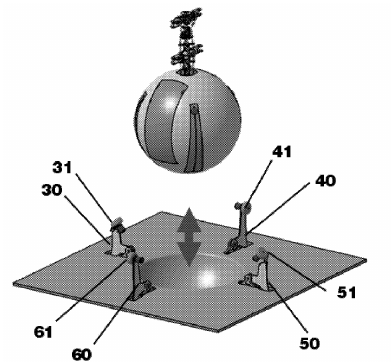
Figure 34. The unmanned aerial vehicle with spherical housing and the landing platform for it [89]. 30, 40, 50, and 60, levers; 31, 41, 51, and 61, drive